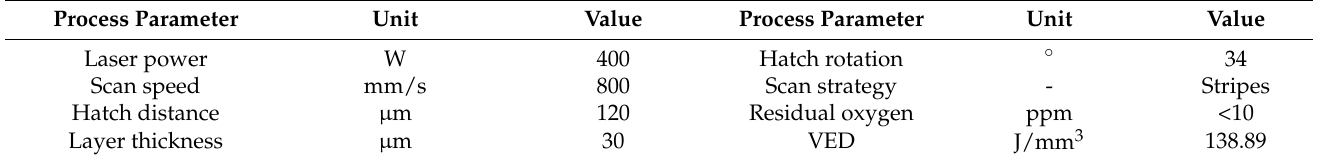
Table 2. Process parameters for L-PBF processing of Cu-Cr-Nb samples and their reinforced